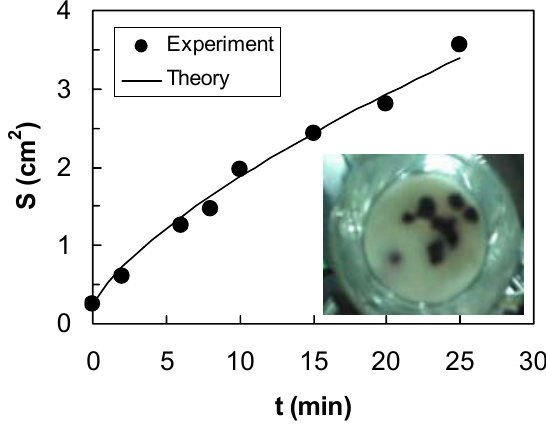
Fig. 1 Time dependence of the total projected area, S , of the Li 2 Se 2 clouds surrounding the selenium pearls during their dissolution. The theoretical line is drawn by Eq. (6). The inset shows the dissolution of Se pearls at 10 min after the beginning of process (the photograph is taken from the bottom of the reaction